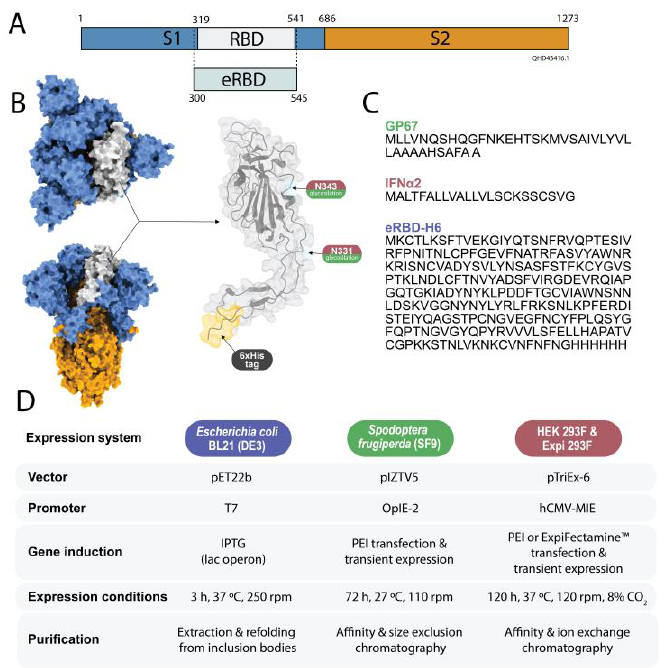
Figure 2. Protein design and production. ( A ) Selected segment of the subunit S1 of the SARS-CoV-2 spike glycoprotein used as model. The “e” in eRDB means extended, to indicate the inclusion of a cationic region from the viral capsid protein, beyond (at the N-terminus of) the consensus limits of the RDB segment. ( B ) Molecular model of the whole spike protein trimer (PDB: 6VXX). In grey, the selected eRDB domain, including the H6 tag and indicating the two glycosylation sites. ( C ) The explicit amino acid sequence of the eRBD construct and the used signal peptides are also depicted on the right. The C-terminal H6 peptide is included here. ( D ) The main features and working conditions of the production platforms used in this study are indicated.